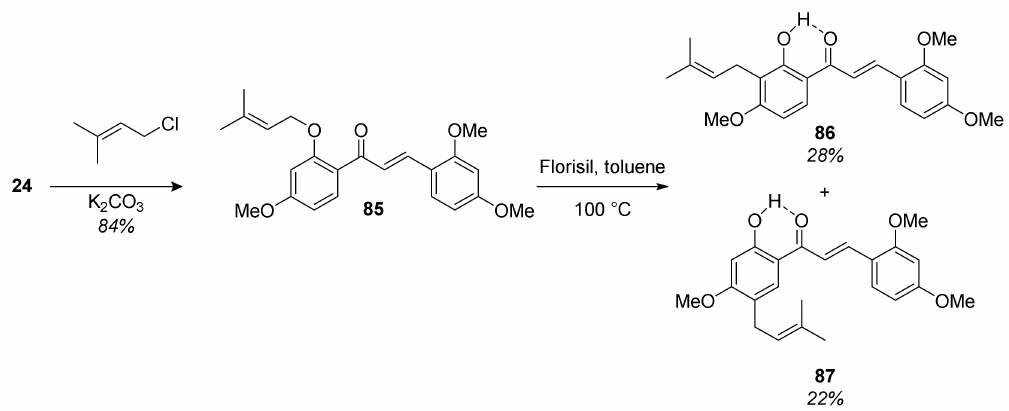
Figure 25. Synthesis of chalcone 86 .